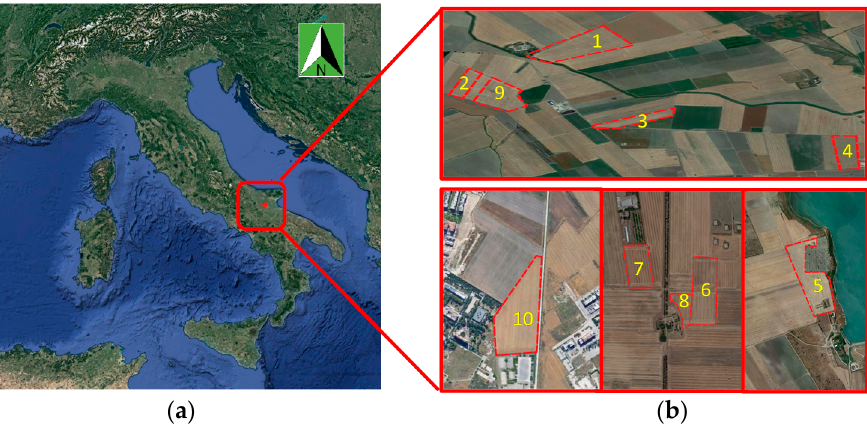
Figure 1. Italy ( a ) and in the red box Foggia province and ( b ) the ten fields studied